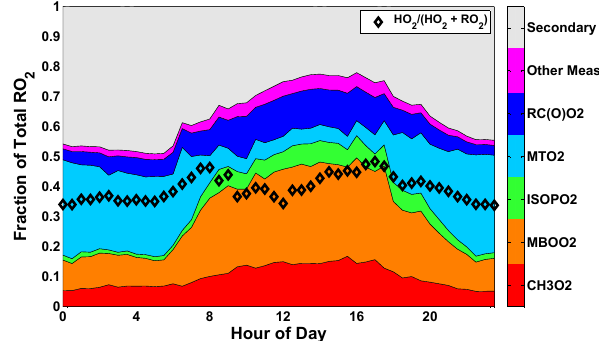
Fig. 4. Modeled distribution of organic peroxy radicals from the base simulation. Groups include methyl peroxy radical (red), first- generation peroxy radicals of MBO (orange), isoprene (green) and monoterpenes (cyan), total acyl peroxy radicals (blue), first- generation radicals from oxidation of other measured VOC (ma- genta), and “secondary” radicals resulting from oxidation of model- predicted, unmeasured VOC (gray). The ratio of HO 2 to total per- oxy radicals is also shown (black